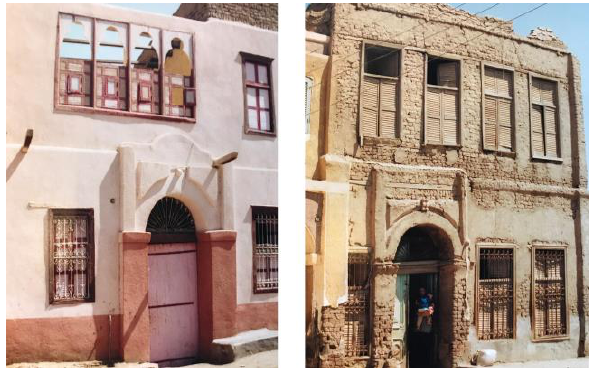
Figure 6. Building plastered and semi plastered mud